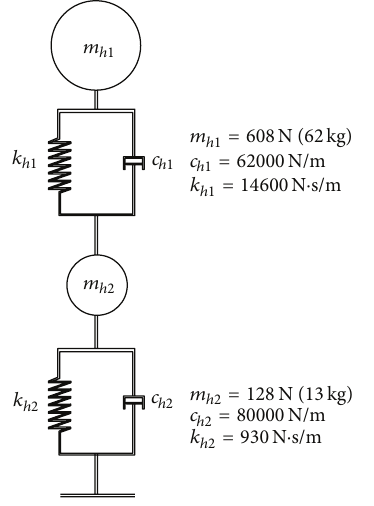
Figure 8: Human body model